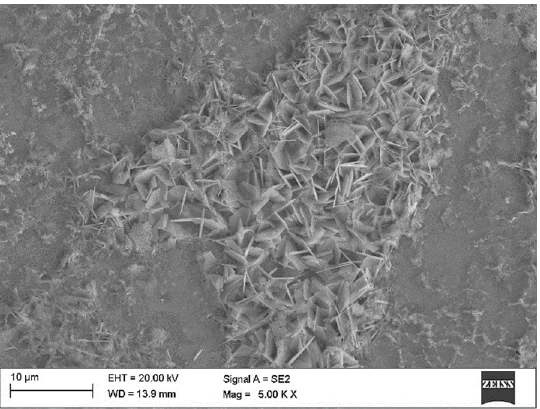
Figure 10. Examples of SEM observations of the M2 sample group after corrosion tests.